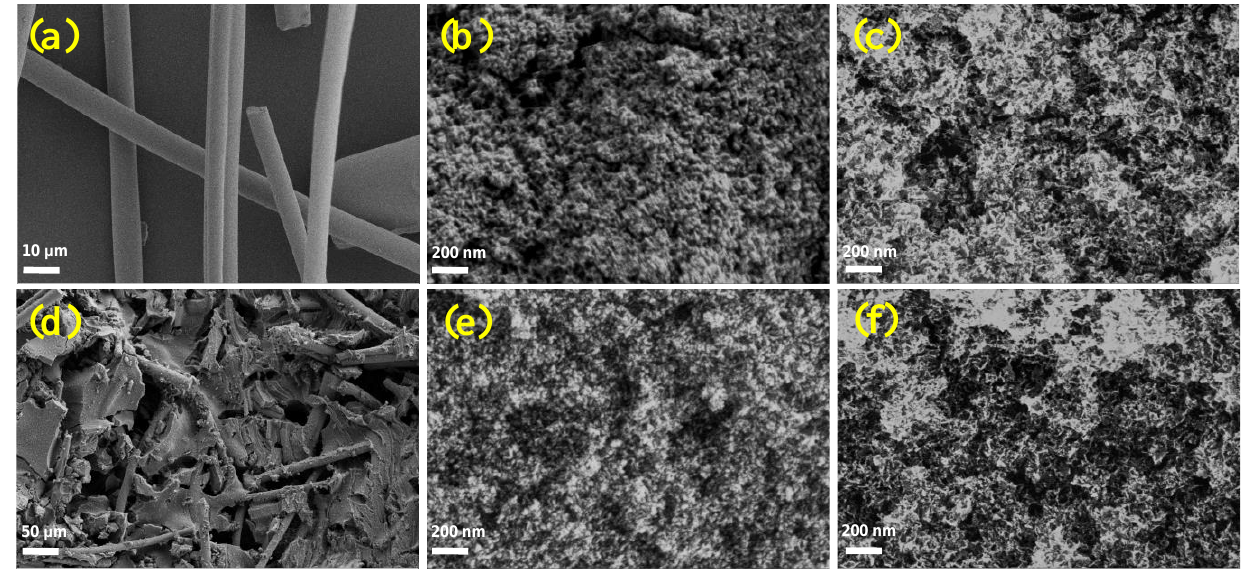
Figure 3. SEM images of the mullite fibers ( a ), AM0 as prepared ( b ) and after heat treatment at 1300 °C ( c ), AM4 as prepared ( d , e ), and after heat treatment at 1300 °C ( f ).